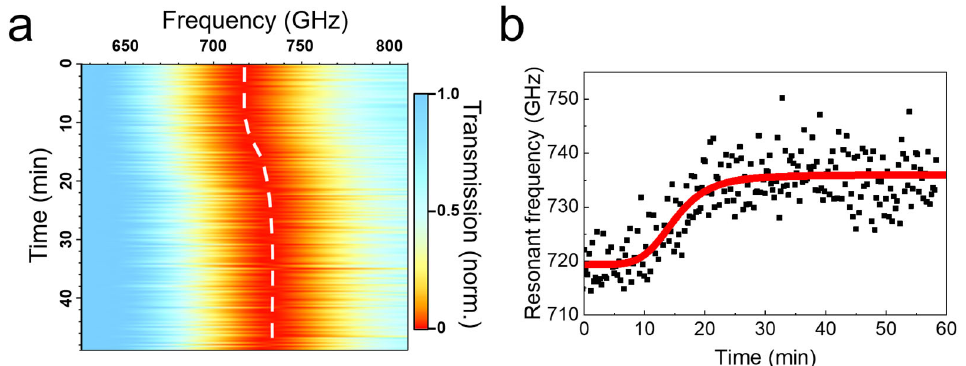
Figure 3. ( a ) A color-scale plot of the normalized transmission amplitude as a function of circulation time of the PS solution. ( b ) The extracted (black dots) resonant frequency as a function of the circulation time. Red line indicates the fitted curve to the experimental data.